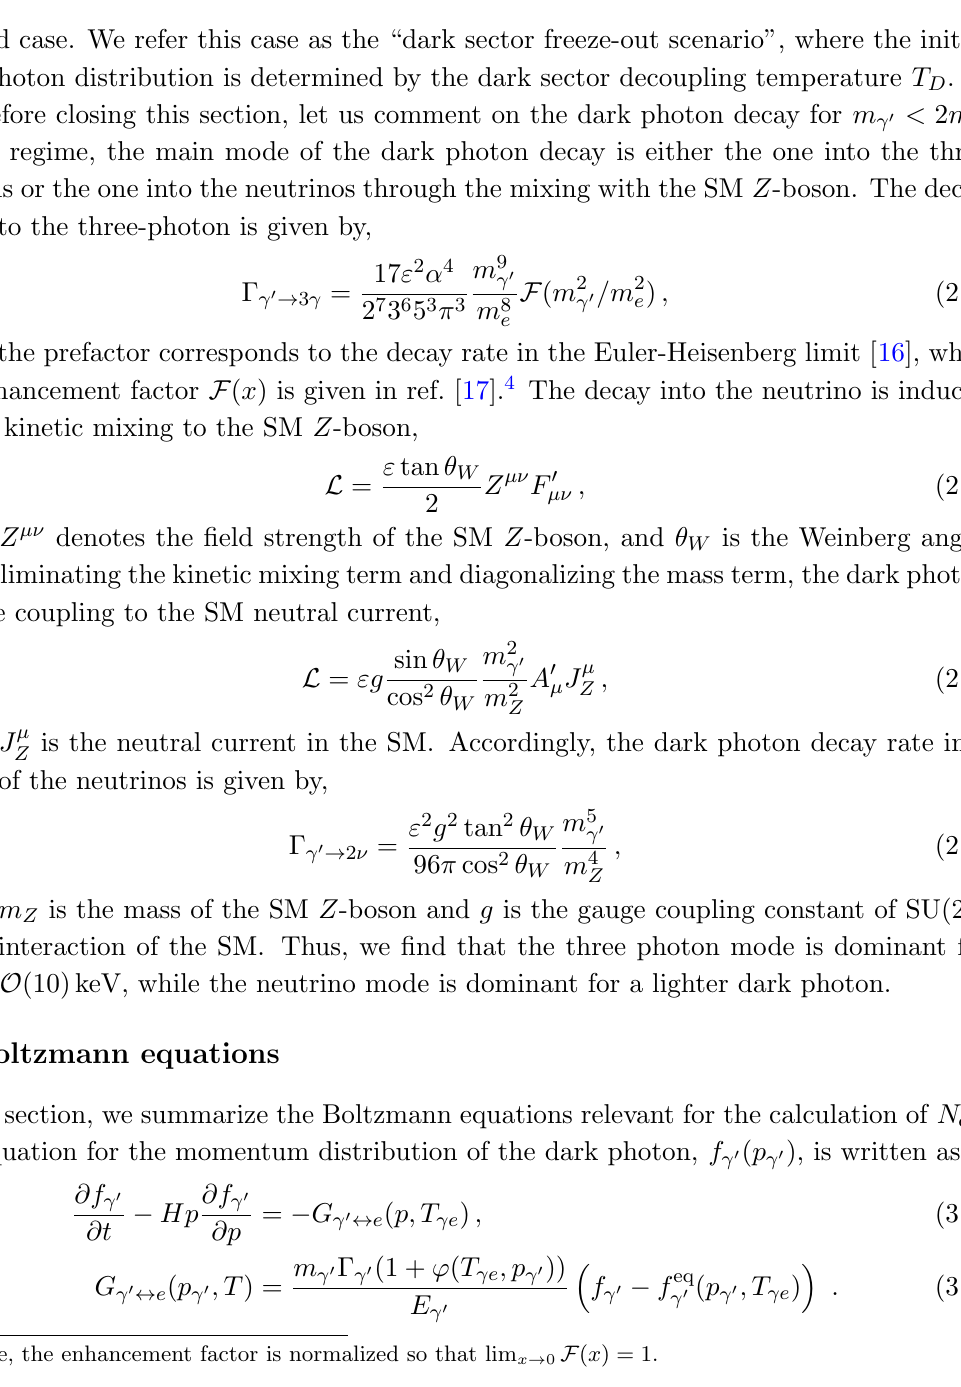
Figure 1 . The Feynman diagrams relevant for the dark photon decay (left), annihilation (middle) and the Compton-scattering like process